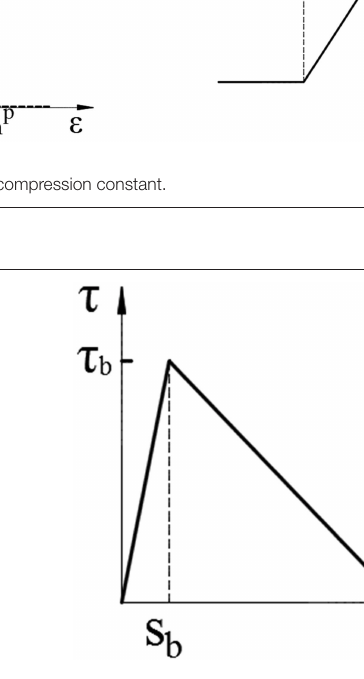
FIGURE 3 | Bond-slip relation between composite and masonry